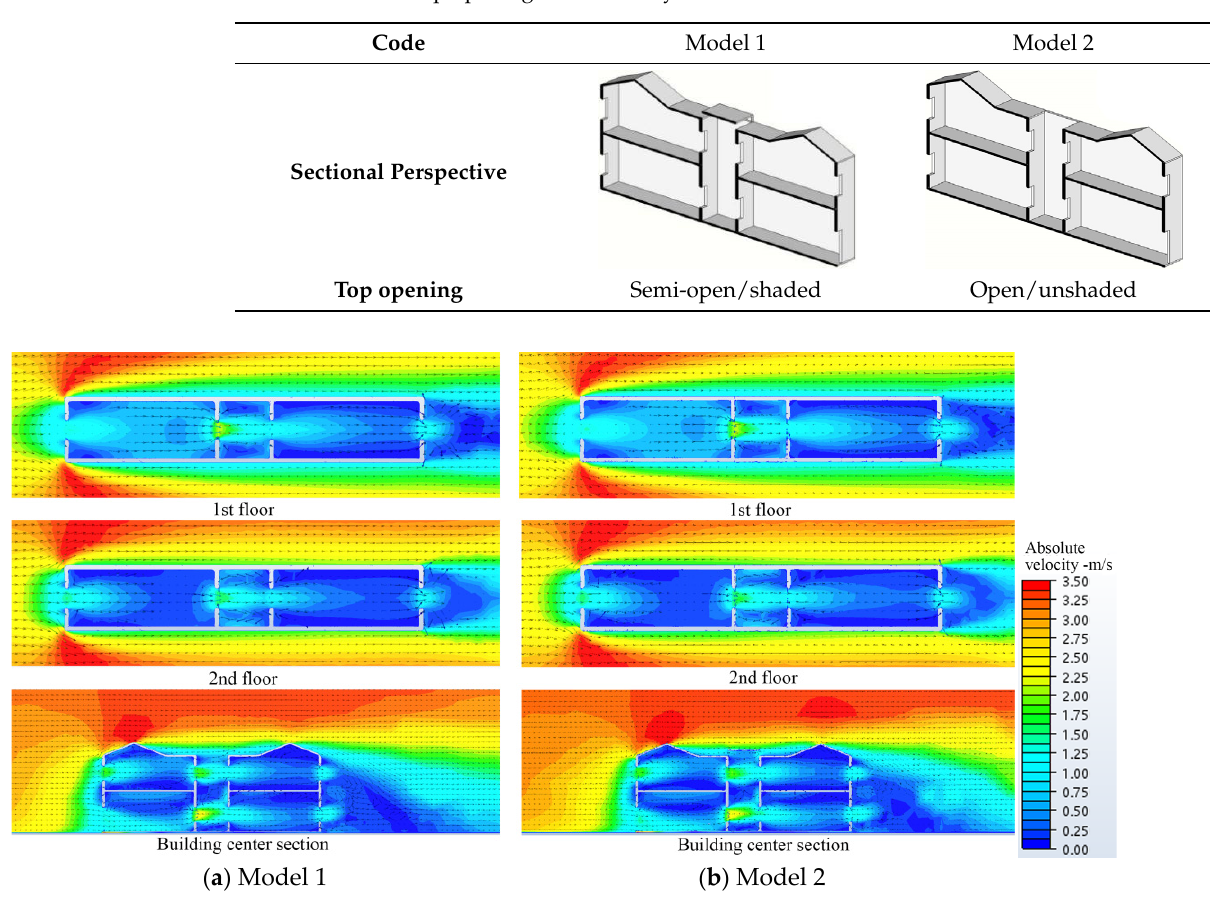
Figure 6. Simulated spatial distributions of V a in Models 1–2 at 12:00 at 1.2 m height on each floor. Table 4. Different top openings of the